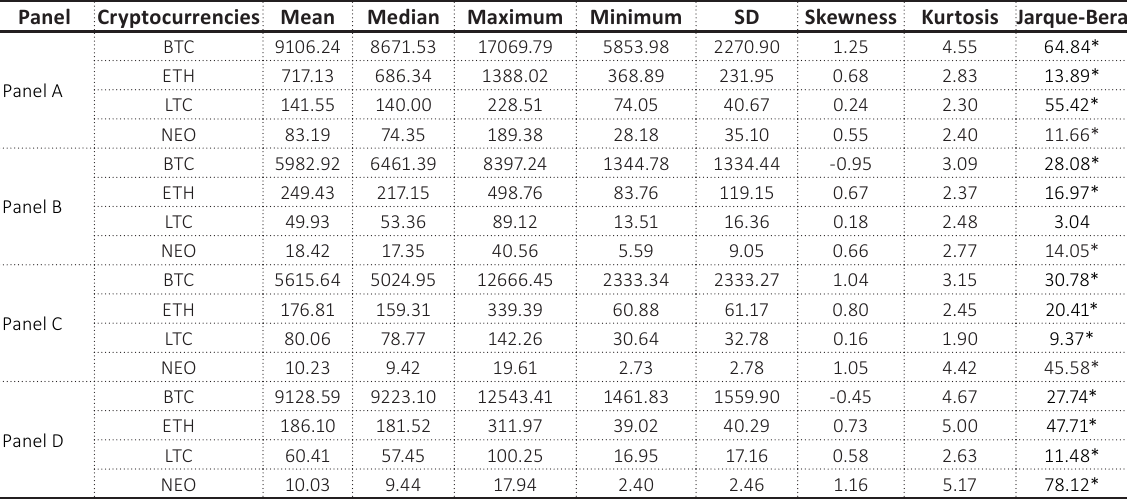
Table 1. Summary statistics of cryptocurrencies